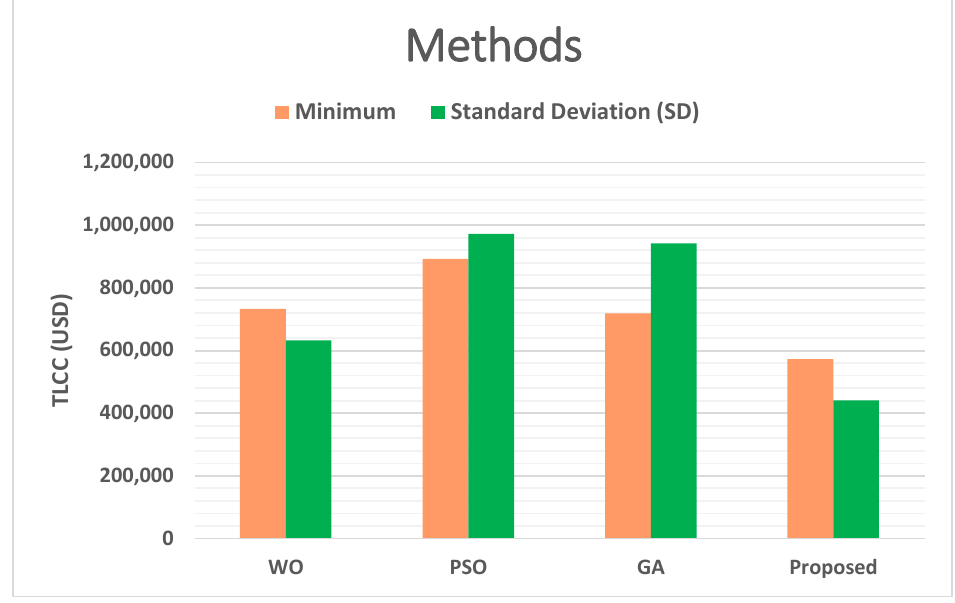
Figure 3. Comparison of TLCC (minimum and SD) for solar/wind/battery/ROD. The comparison of TLCC concerning wind/battery/ROD is represented in Table 2.